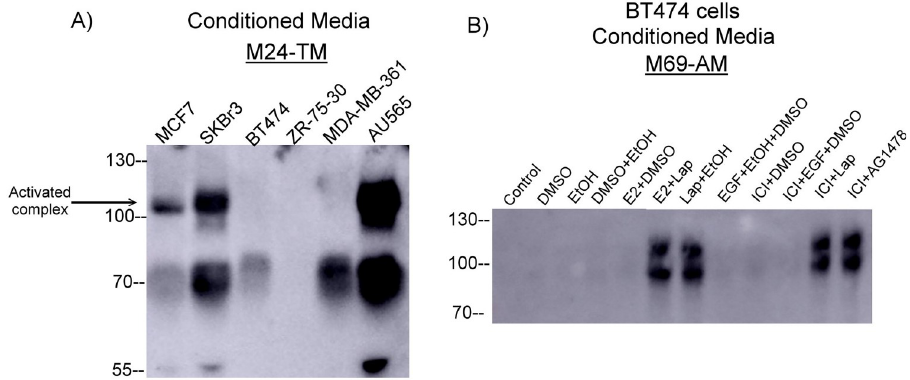
Fig 2. Screening breast cancer cells revealed robust matriptase activation only when ER-positive cells are treated with ICI and Lapatinib. A) Breast cancer cells were seeded in 35mm dishes and when ~80% confluent, incubated for 24 hours in 1ml of basal media + 10% FBS. Conditioned media was collected and the level of activated matriptase was determined by immunoblotting with the total matriptase antibody. B) BT474 cells were seeded in 35mm dishes and when ~80% confluent, washed twice with sterile PBS, and pre-treated with 1uM ICI in serum-free media for 48 hours. Cells were then treated with either 20ng/ml EGF, 10nm estradiol (E2), 1uM ICI, or 5.4uM Lapatinib (Lap) with appropriate solvent controls for 48 hours. Conditioned media was collected and the level of activated matriptase was determined by immunoblotting with the activated matriptase antibody. Panels were the highest quality representative of 4 biological